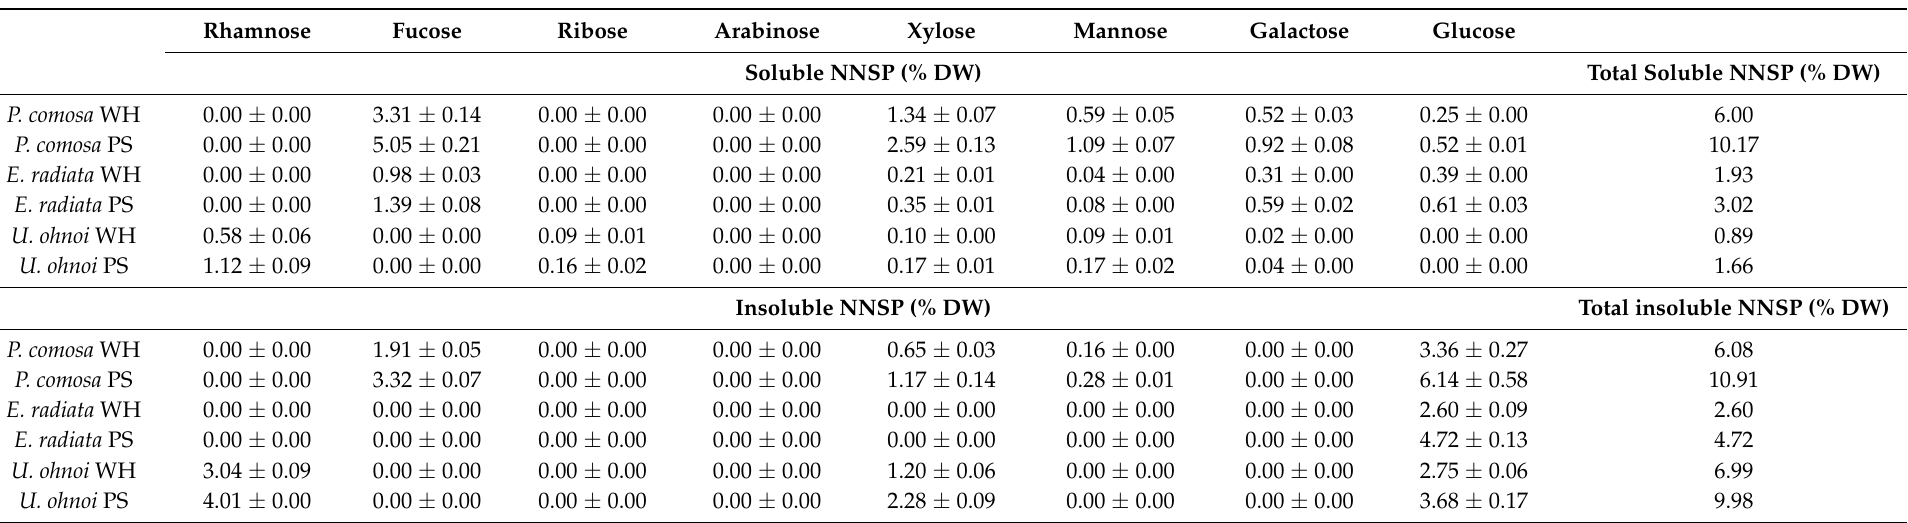
Table 3. Total neutral non-starch polysaccharides content of WH seaweeds and their PS extracts (DW) (percentage ± SD). Rhamnose Fucose Ribose Arabinose Xylose Mannose Galactose Glucose Soluble NNSP (% DW) Total Soluble NNSP (%